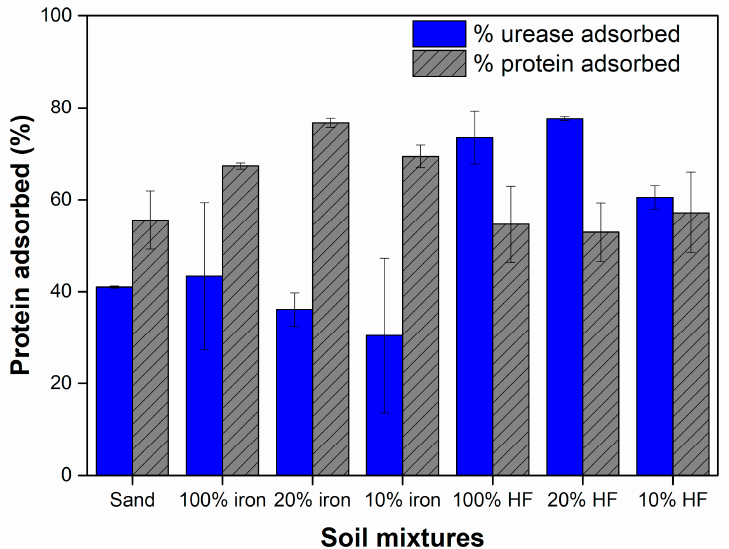
Figure 2. The percentage of overall protein adsorbed, and urease adsorbed, from the initial total protein extract. The total amount of adsorbed proteins was obtained through Nanodrop measurements at 280 nm wavelengths before and after adsorption. Urease concentrations were obtained from targeted PRM LC/MS analysis. Results shown are the averages of three and two independent experiments for the % adsorbed urease and % total proteins adsorbed, respectively. Error bars represent the standard error.